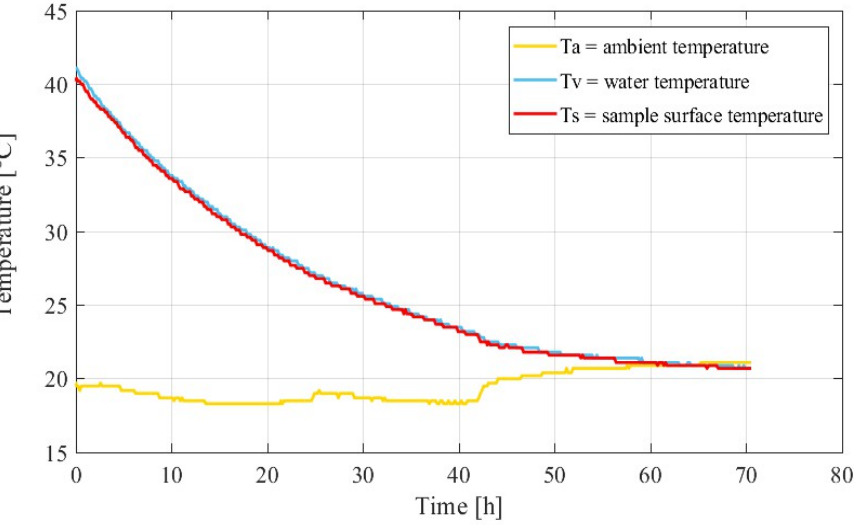
Figure 2. λ determined by authors with Nordtest (www.nordtest.org, accessed on 20 December 2021) [34] and standard methods ASTM [1]: calibration with ASTM (hot water) temperature